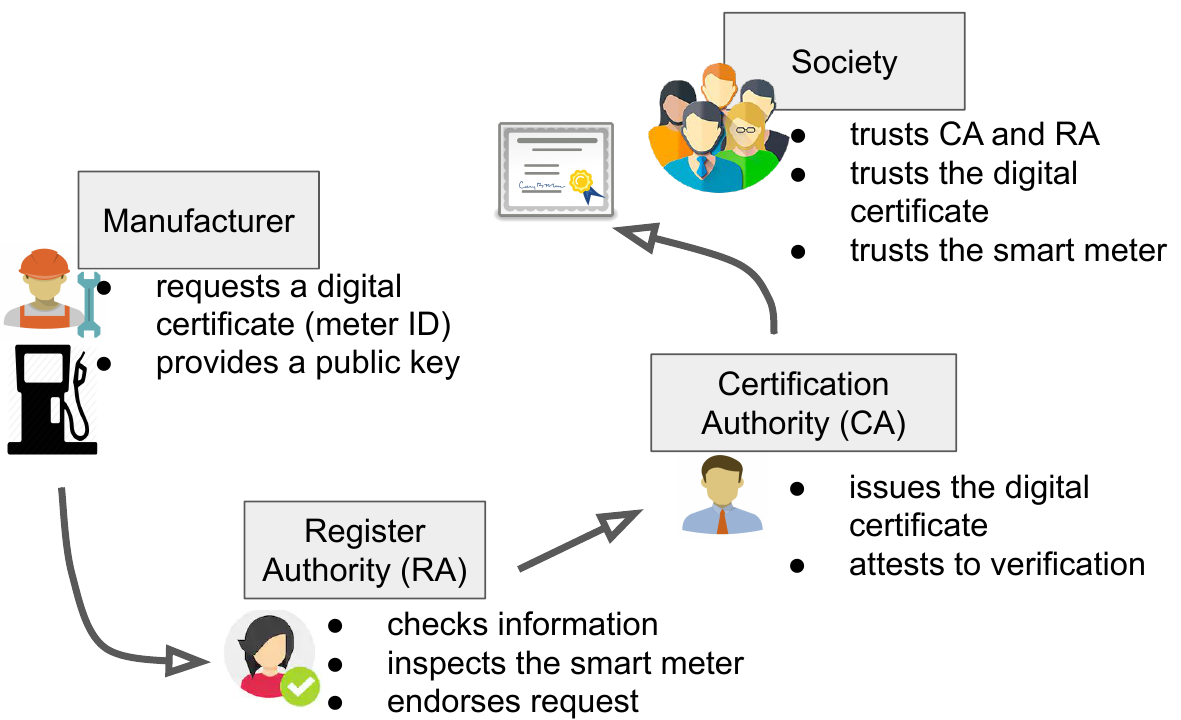
Figure 2. CA-based PKI scheme describing the RA and CA